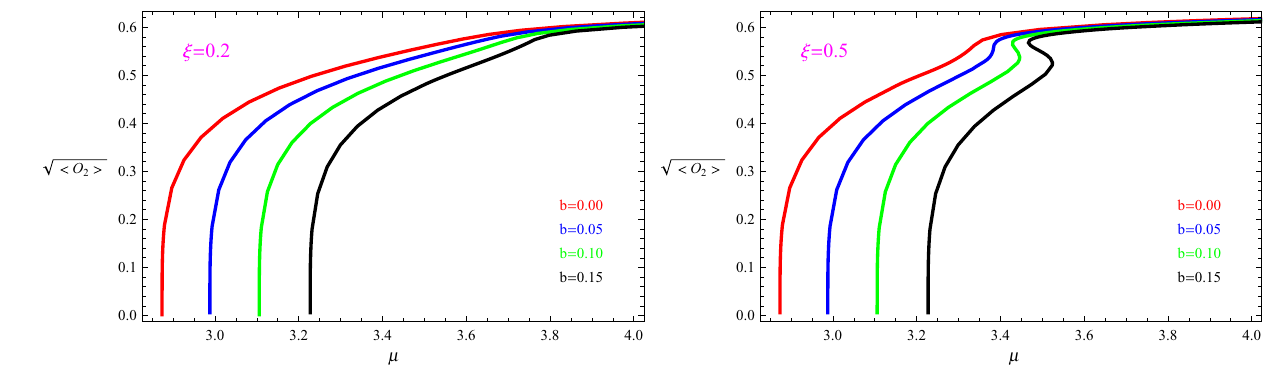
Fig. 1 The condensate as a function of the chemical potential with the fixed coefficient ξ = 0 . 2 (left) and ξ = 0 . 5 (right) for different values of the Born–Infeld parameter b . The four lines in each panel